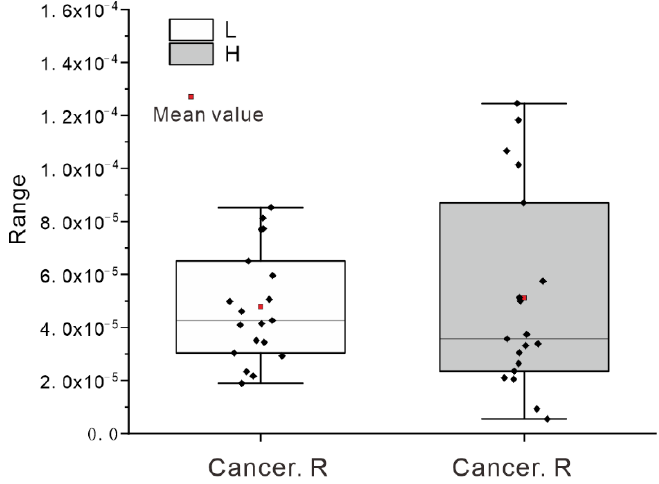
Figure 6. Carcinogenic risks (Cancer. R) for the arsenic in the river waters of the Issyk − Kul Basin during the period with high river flow (H, n = 19 ) and the period with low river flow (L, n = 19 ).